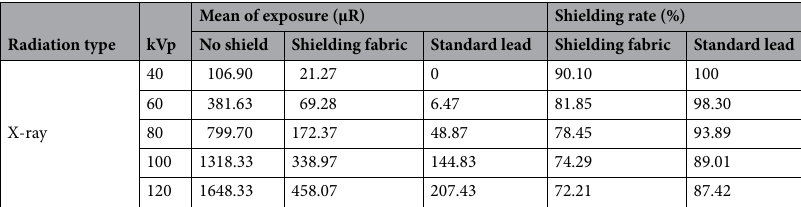
Table 4. Shielding performance evaluation result of tungsten-coated shielding